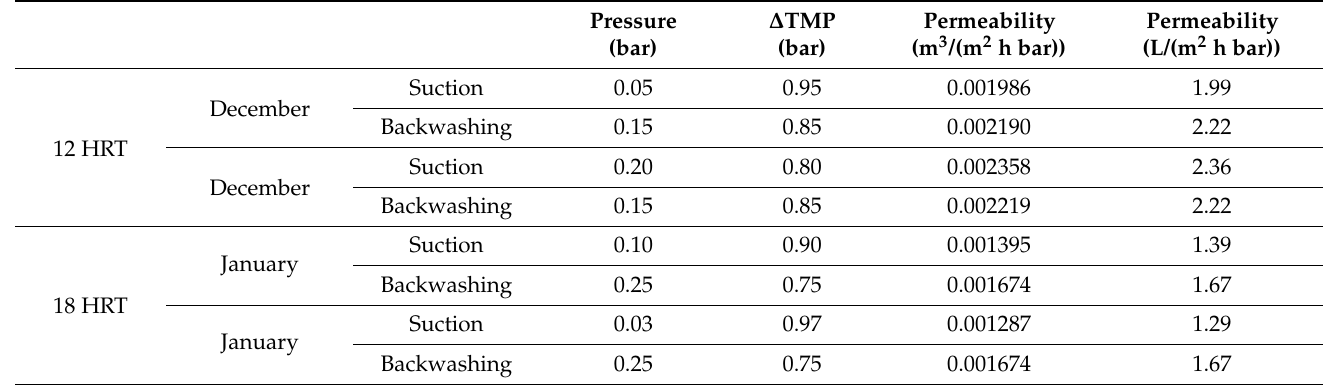
Table 1. Permeability working values, where TMP is the transmembrane pressure.